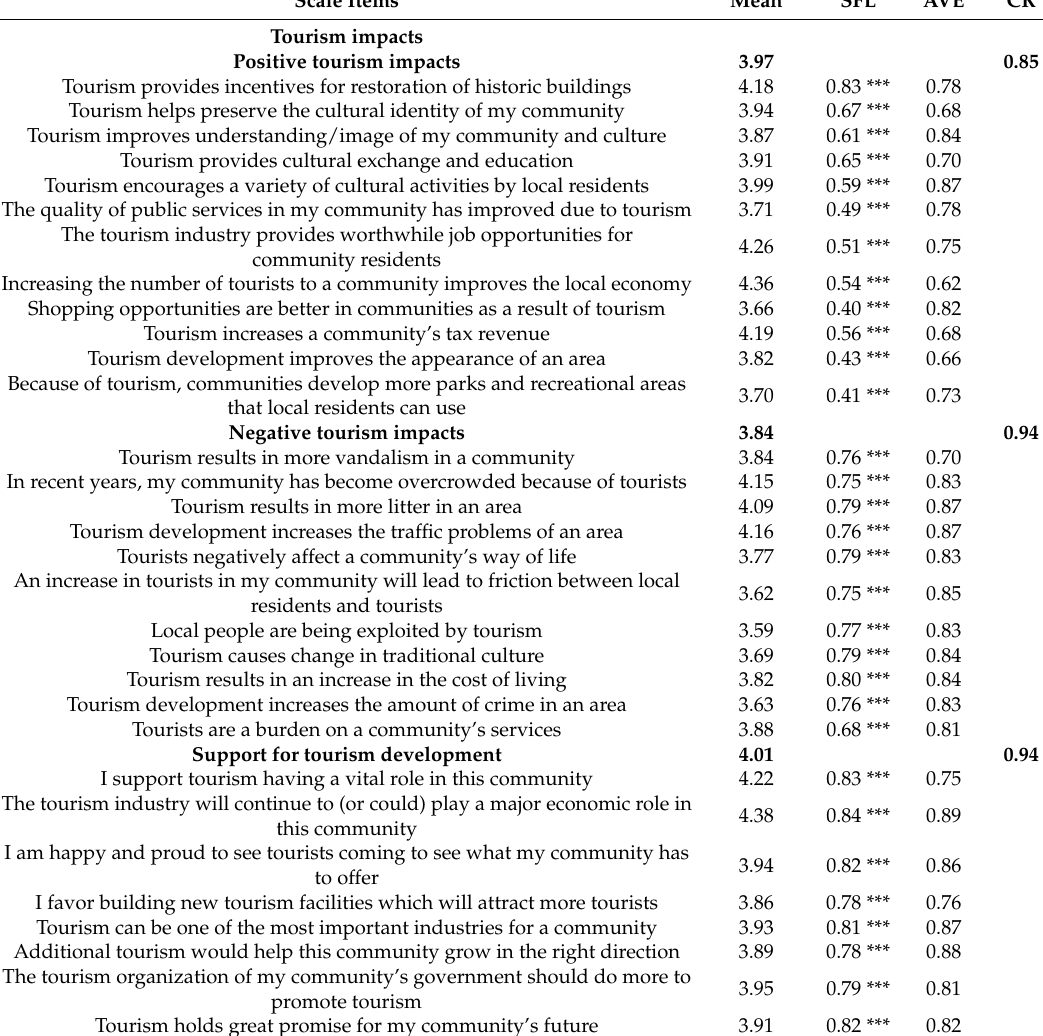
Table 1. Means, factor loadings, and reliabilities for positive tourism impacts, negative tourism impacts, and support for tourism